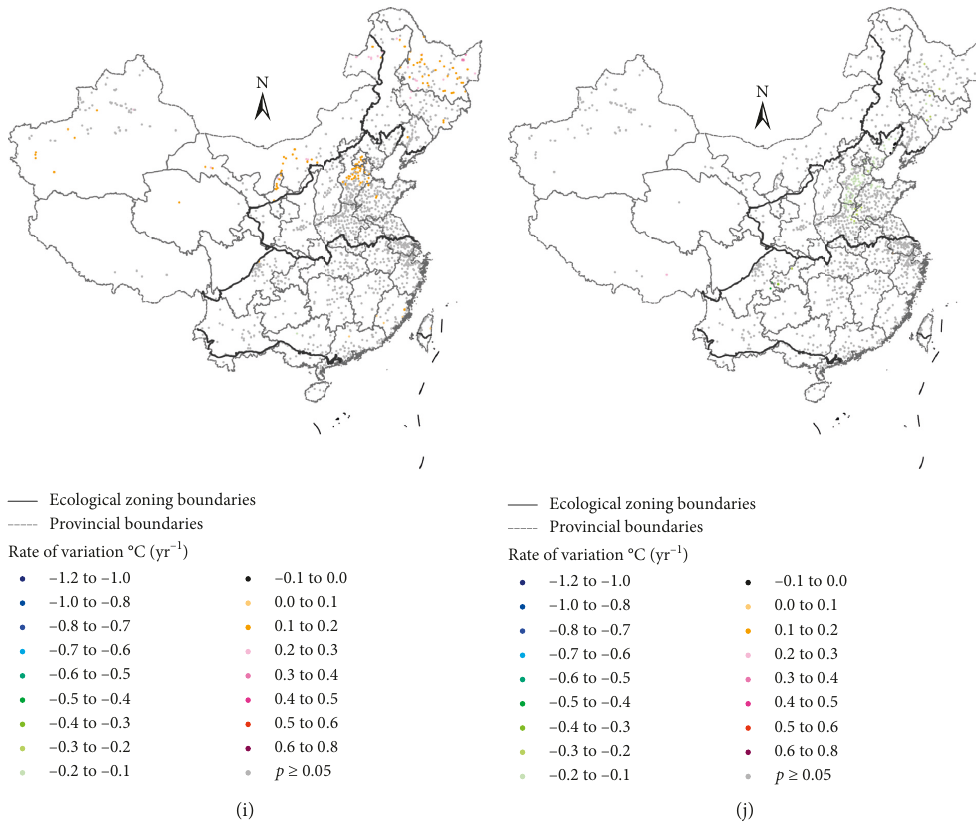
Figure 2: Spatial distribution of the annual and seasonal change rates of LSTs in rural regions during the daytime and night-time from 2003 to 2013 in the five environmental regions of China: (a–e) the results during the whole year, winter, spring, summer, and autumn daytime, respectively; (f–j) corresponding values during night-time. (a) Annual day. (b) Winter day. (c) Spring day. (d) Summer day. (e) Autumn day.